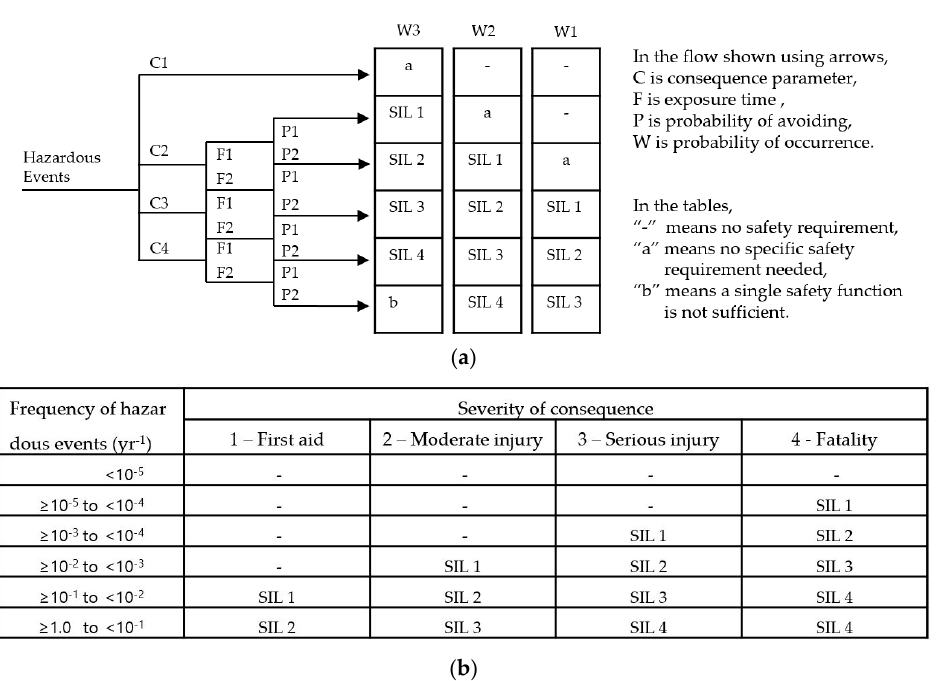
Figure 2. ( a ) An example of the SIL graph method for determining the required risk reduction, ( b ) An example of the SIL matrix method for determining the required risk reduction ( adapted from [37]).